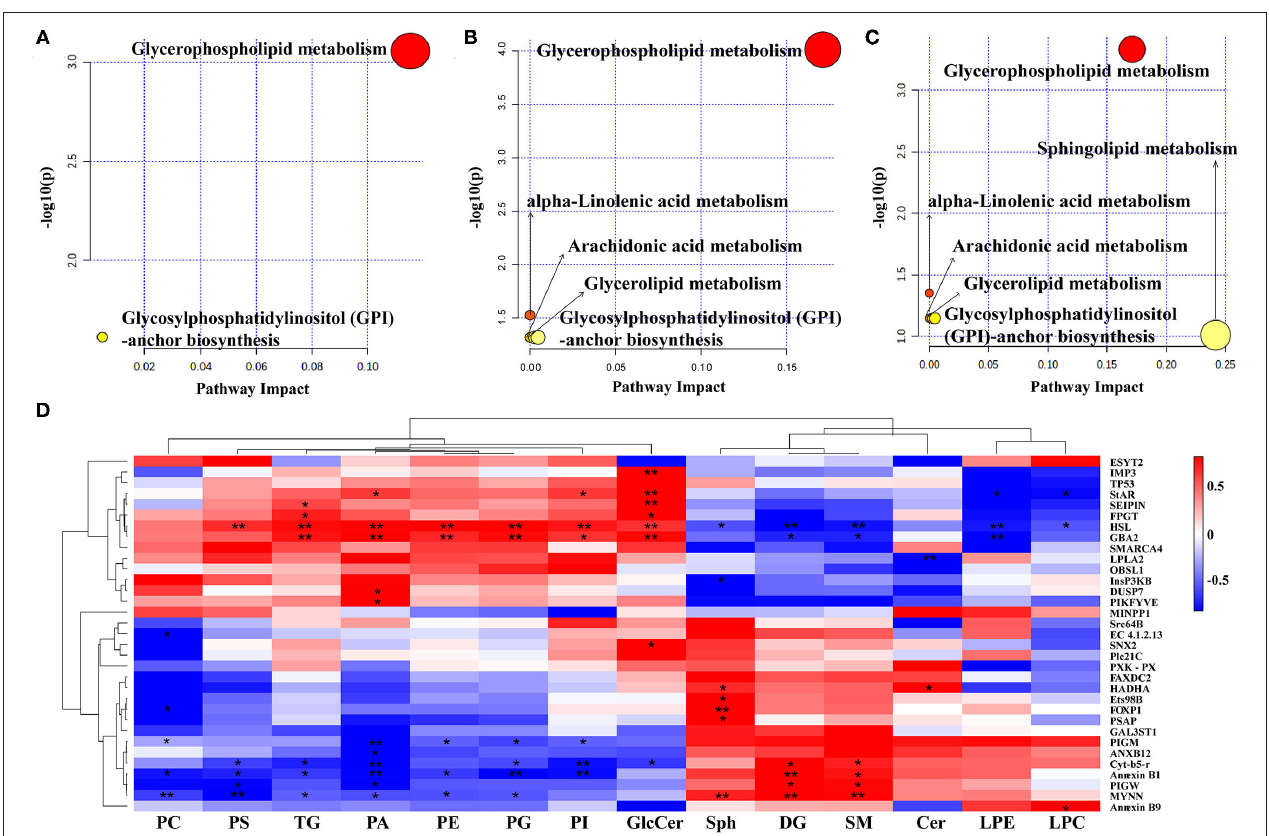
FIGURE 11 | Comprehensive analysis of lipidomic and transcriptomic analysis. Pathway analysis of the differential metabolites. (A) Enriched pathway of control vs. SL. (B) Enriched pathway of control vs. EL. (C) Enriched pathway of control vs. KO. (D) Correlation analysis between differential metabolites and differentially expressed genes. Red squares are positive correlations, while blue squares are negative correlations, and the statistical significance is indicated by *( p < 0.05), **( p <